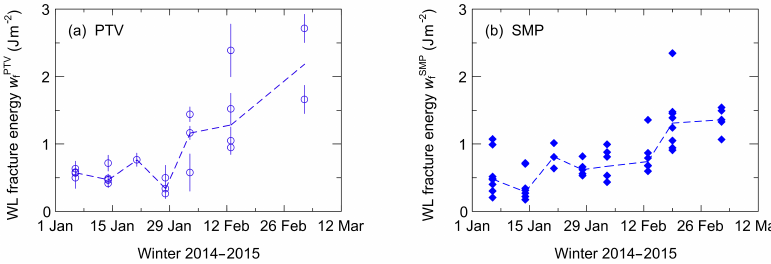
Figure 4. Weak layer specific fracture energy derived from (a) the bending of the slab via PTV analysis ( N = 22) with vertical lines denoting measurement uncertainty and (b) the SMP signal analysis ( N = 48). Dashed lines connect the median values per day.